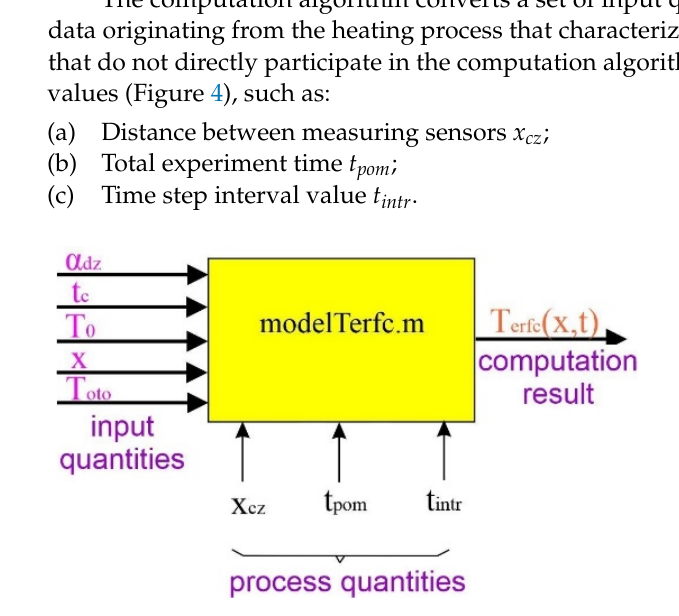
Figure 4. Identification of Terfc(x,t) model signals.